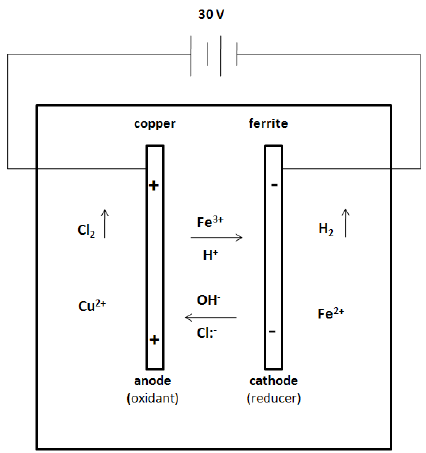
Figure 19. Scheme 2D, simplified representation of the electrochemical interactions as from photo-redox process the grating (image) [PVA-OH-Fe 2+ ] * . The formation of the image (grating) without voltage is: [PVA-OH-Fe 2+ ], when voltage is applied is: [PVA-OH-Fe 2+ ] * . This * is, to differentiate both